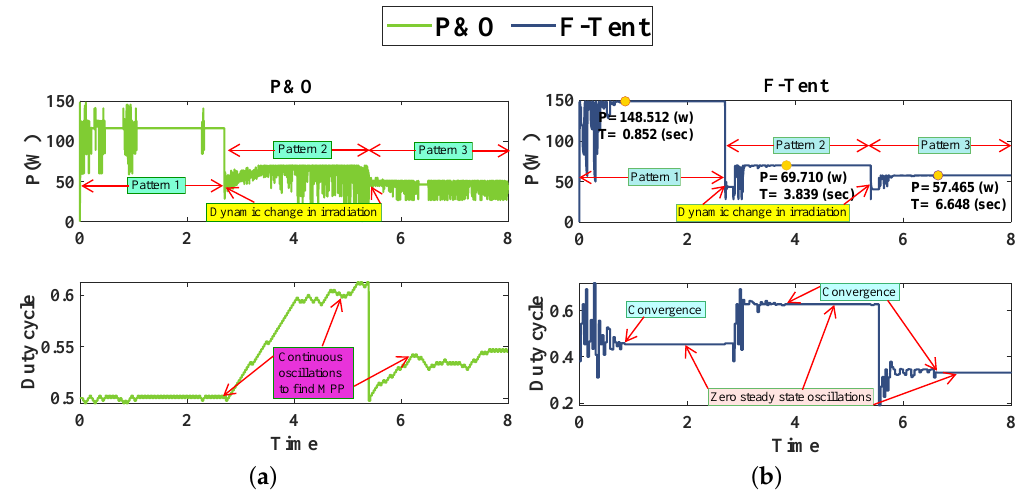
Figure 10. The obtained power and duty cycle by the P&O and the fractional tent map over the step changes in irradiance condition from pattern 1 to 2 to 3 in the case of 4S connected S36 PV array reconfiguration: ( a ) P&O, and ( b ) F-tent map with